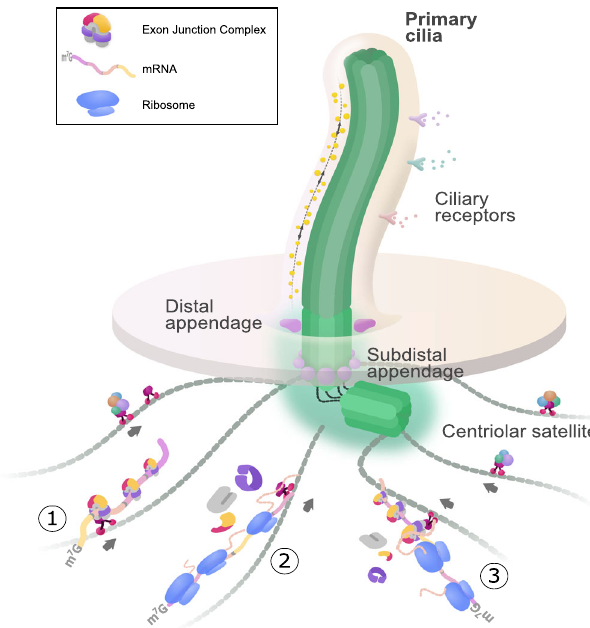
Fig. 7 Multiple pathways for RNA localization toward centrosome. During quiescence, mother centriole tightly attaches to plasma membrane by distal appendages to nucleate the formation of primary cilia. To relay the signals from environment, several receptors are embedded at ciliary